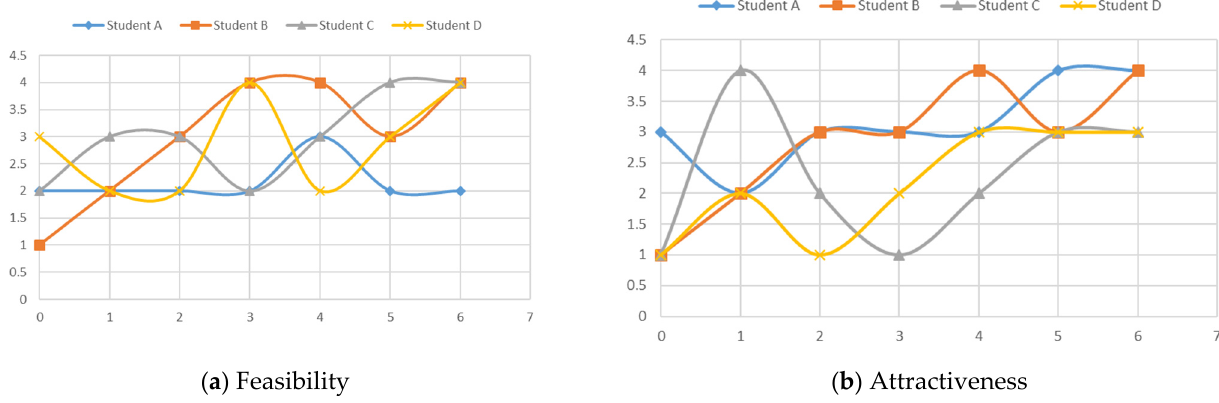
Figure 3. Dynamics of perception of idea ( a ) feasibility and ( b ) attractiveness by four students along the entrepreneurial journey on Likert scale 1–5 (min-max). Checkpoints 0–6 correspond to Table 1.